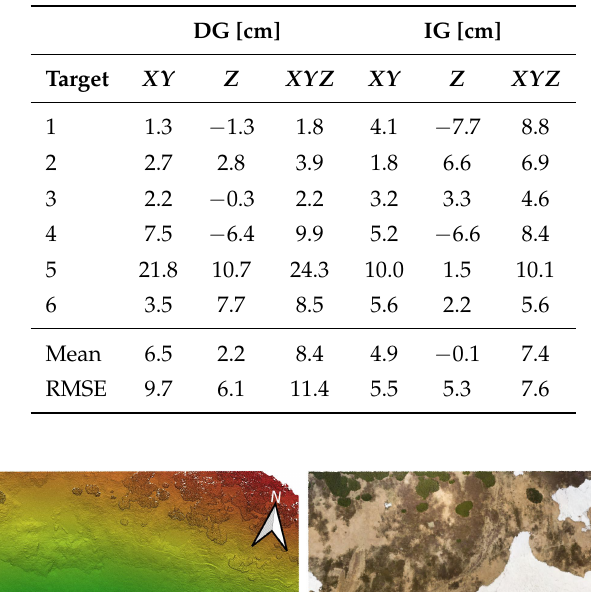
Table 4. The accuracy of direct and indirect georeferencing, determined by using 6 ground targets. In the IG procedure, the accuracy was assessed via the GCPs.